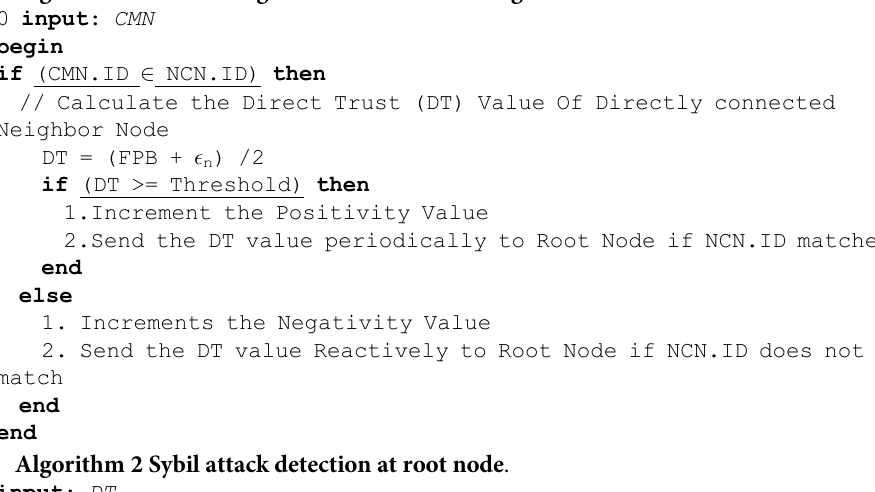
Algorithm 1 Calculating the Direct Trust of Neighbor Nodes .